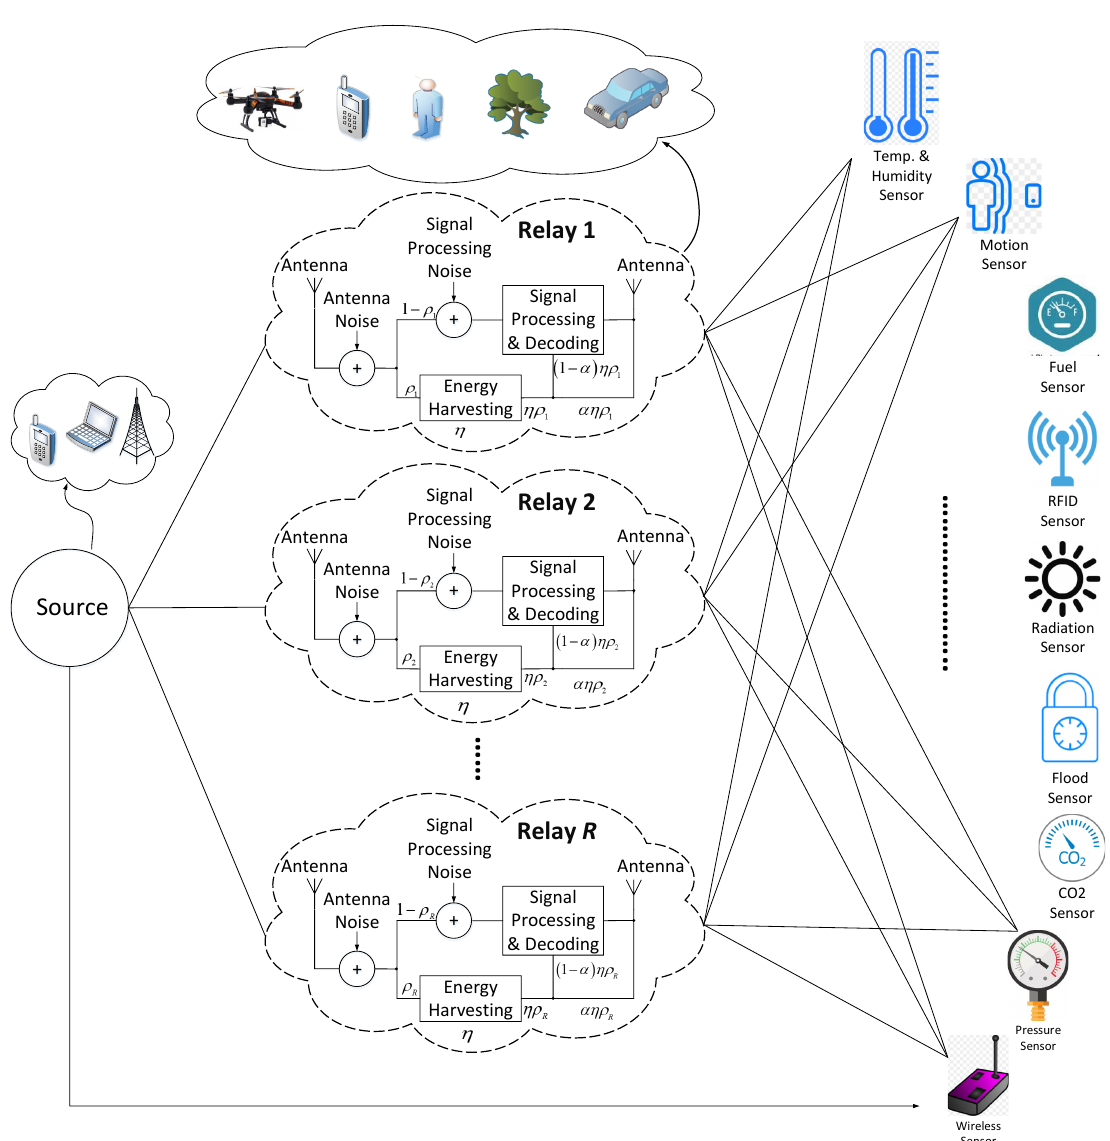
Figure 1. Example scenario of a multi-relay